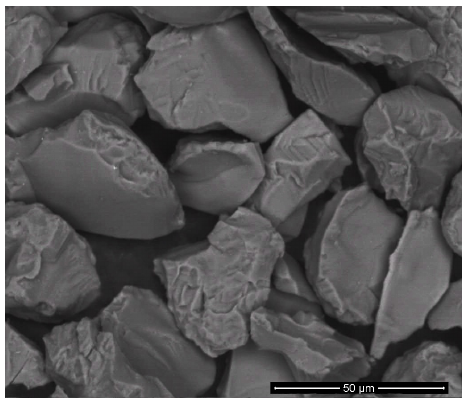
Figure 1. SEM micrographs showing the morphology of the blocky alumina erodent particles (back-scattered electron mode).